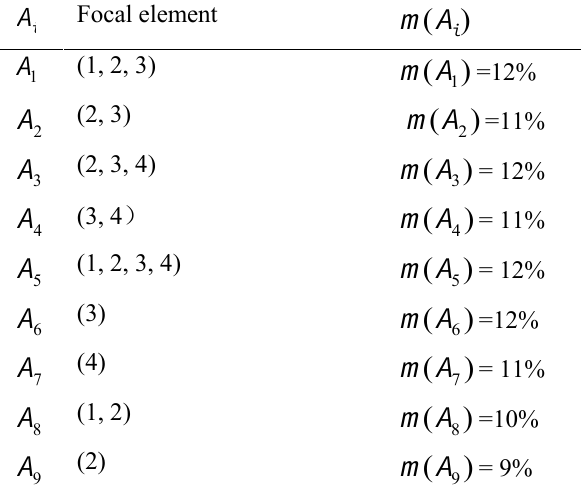
Table 5. Random set measuring urban flood risk.